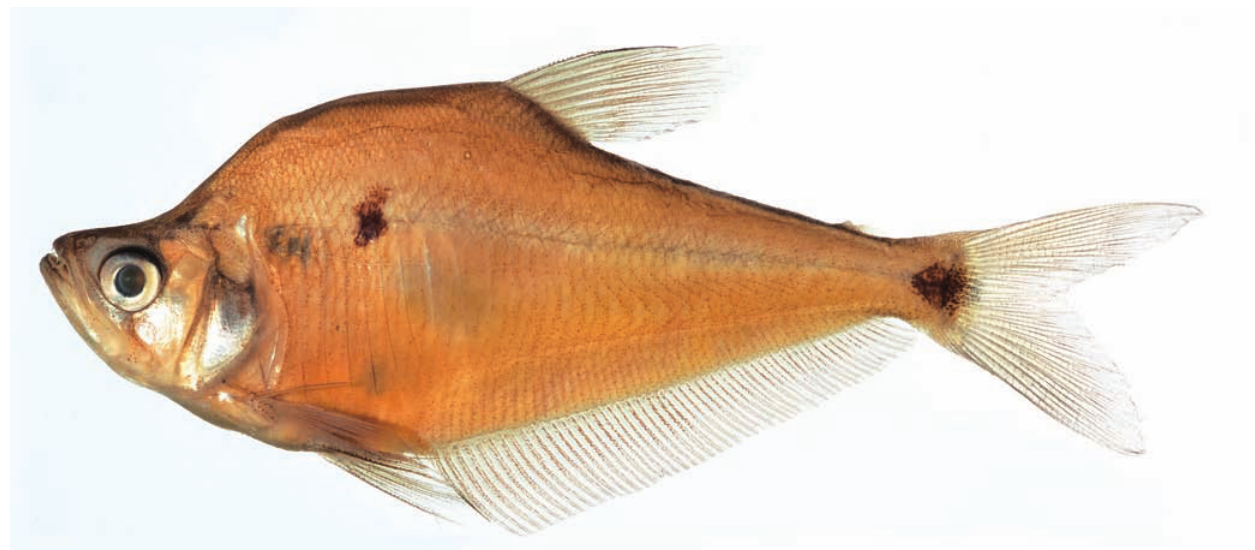
Fig. 8. Charax caudimaculatus , USNM 236877, female, paratype, 95 mm SL, Peru, Madre de Dios, Reserva Nacional de Tambopata, Laguna Cocococha.